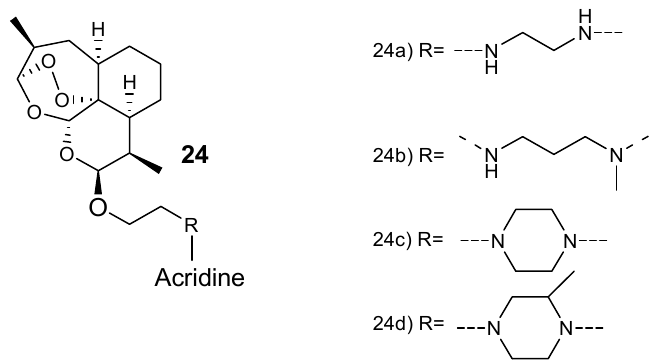
Figure 8. Structure of artemisinin–acridine hybrid compounds 24.